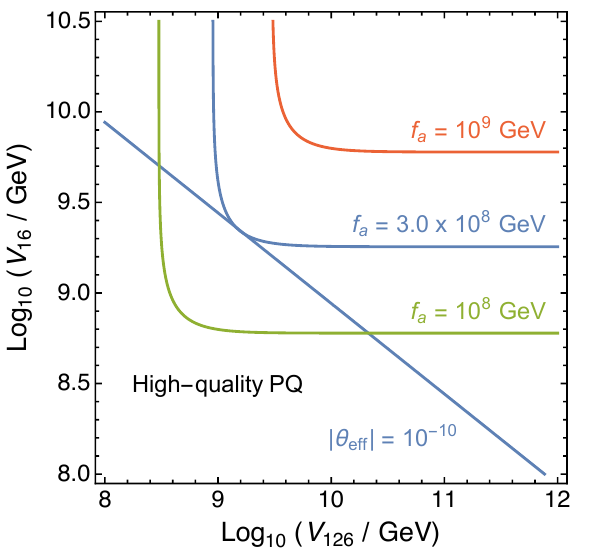
Figure 2 . Parameter space of the accidental SO(10) axion leading to a high-quality U(1) PQ . For the estimate of the induced QCD theta term we used eq. (3.8) with of V (cf. eq. (4.20)), we (cid:12)nd that in order to satisfy the nEDM bound, 16 ; 126